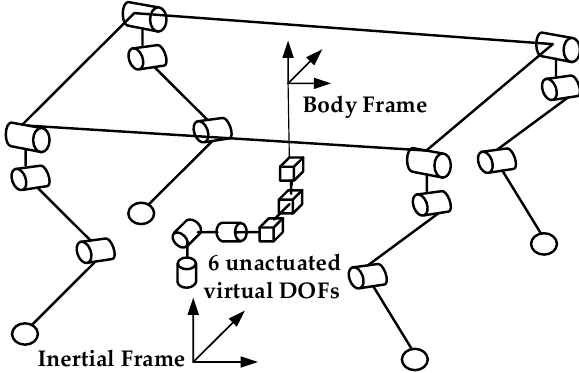
Figure 1. The base frame attached to the robot is connected to the inertial frame via 6 unactuated virtual DOFs.